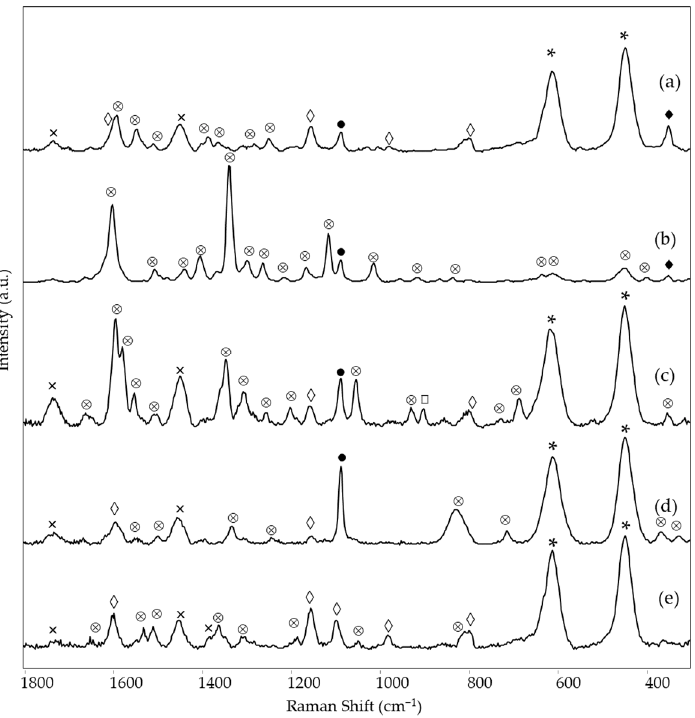
Figure 1. SSE™ Raman spectra of red areas: (a) The grammar of fire—Canto I , area 1, (b) The grammar of fire—Canto II , area 2, (c) The North star and the tree of life , area 1, (d) The North star and the tree of life , area 6 (orange) and (e) Earthquake , area 1. Legend: ⊗ = pigment (for wavenumbers and assignments see Table 2), * = rutile, • = CaCO 3 , ♦ = resin, (cid:3) = Sr 2 MgSi 2 O 7 , (cid:7) = ZnS, × = binder (see